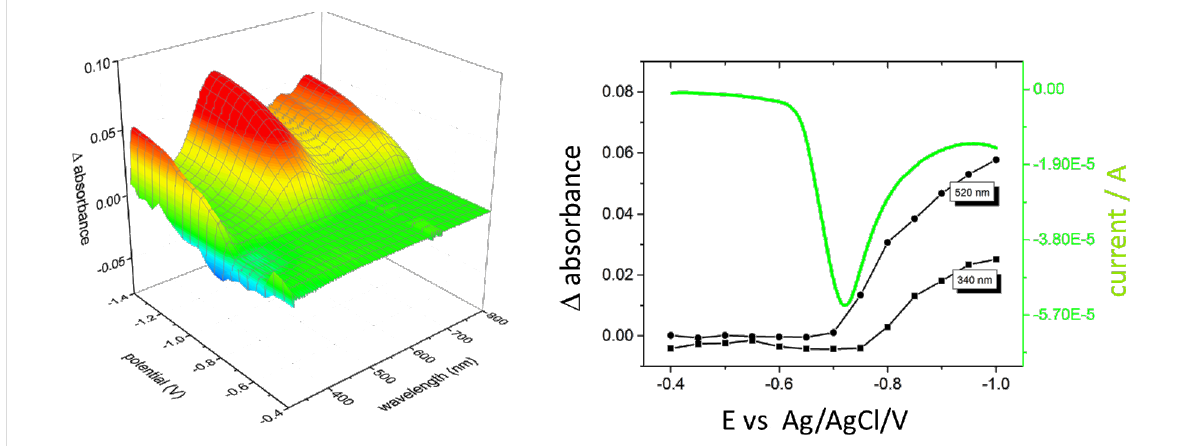
Figure 9: Spectral changes of the [Cp*Rh(bpy)(H 2 O)] 2+ solution as a function of the applied potential (left). Cyclic voltammogram and corresponding changes in absorbance recorded at 521 nm (right). For simplicity, only the part of the potential scan (the reduction process from − 0.4 to − 1.4 V and back) is shown.